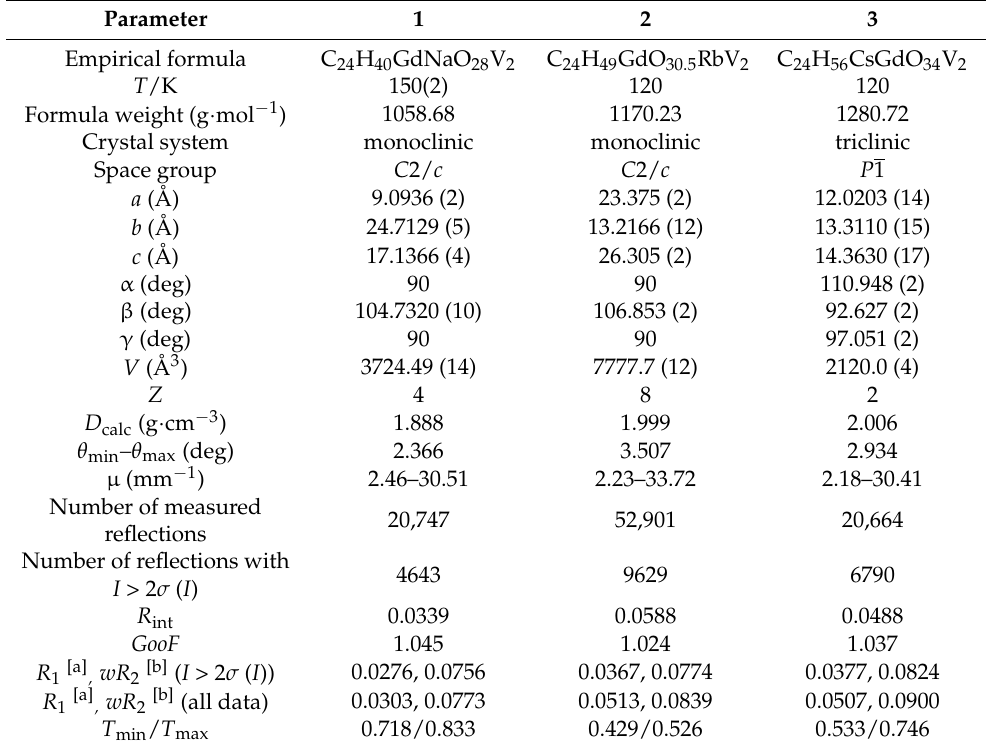
Table 5. Crystallographic parameters and structure refinement details for compounds 1 – 3